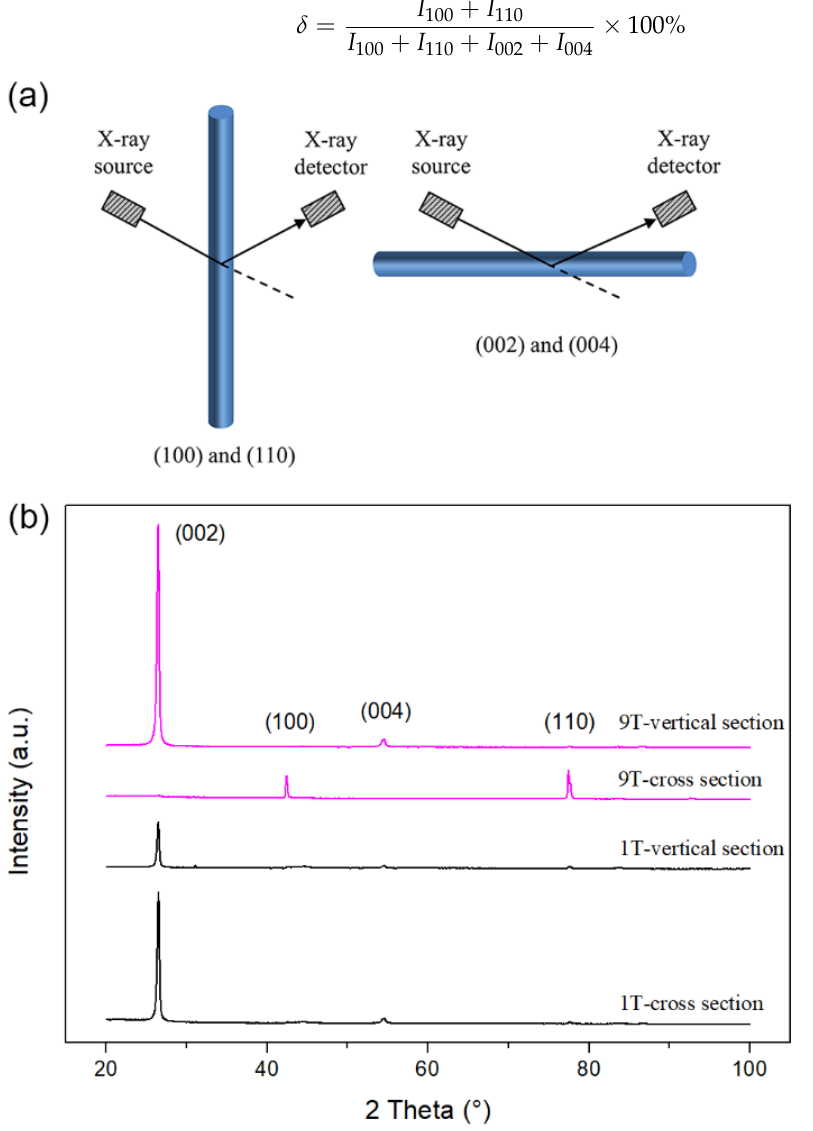
Figure 3. XRD analysis of CF–rubber composites. ( a ) Illustration of alignment effect of CFs on XRD patterns; ( b ) XRD patterns of 1 T and 9 T samples in vertical-section and cross-section.